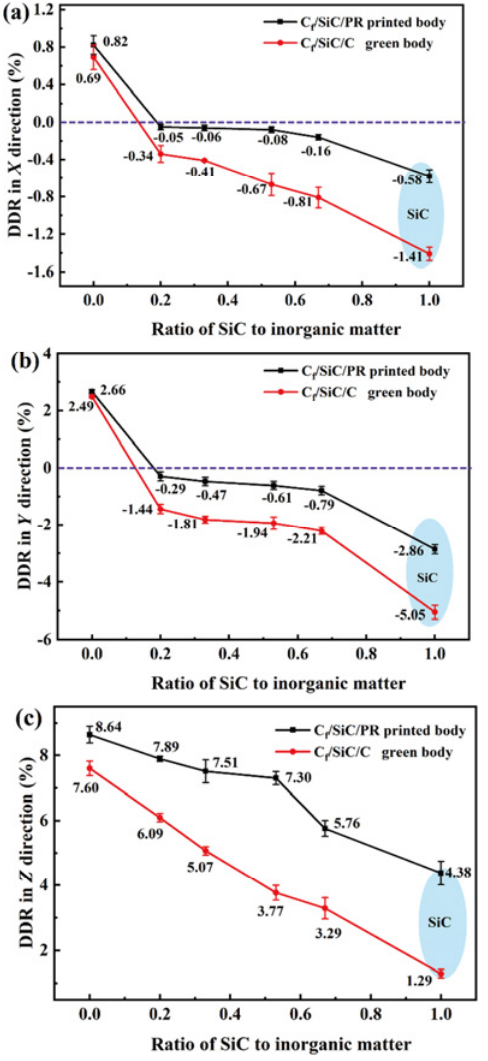
Fig. 7 (a) DDRs in X direction; (b) DDRs in Y direction; and (c) DDRs in Z